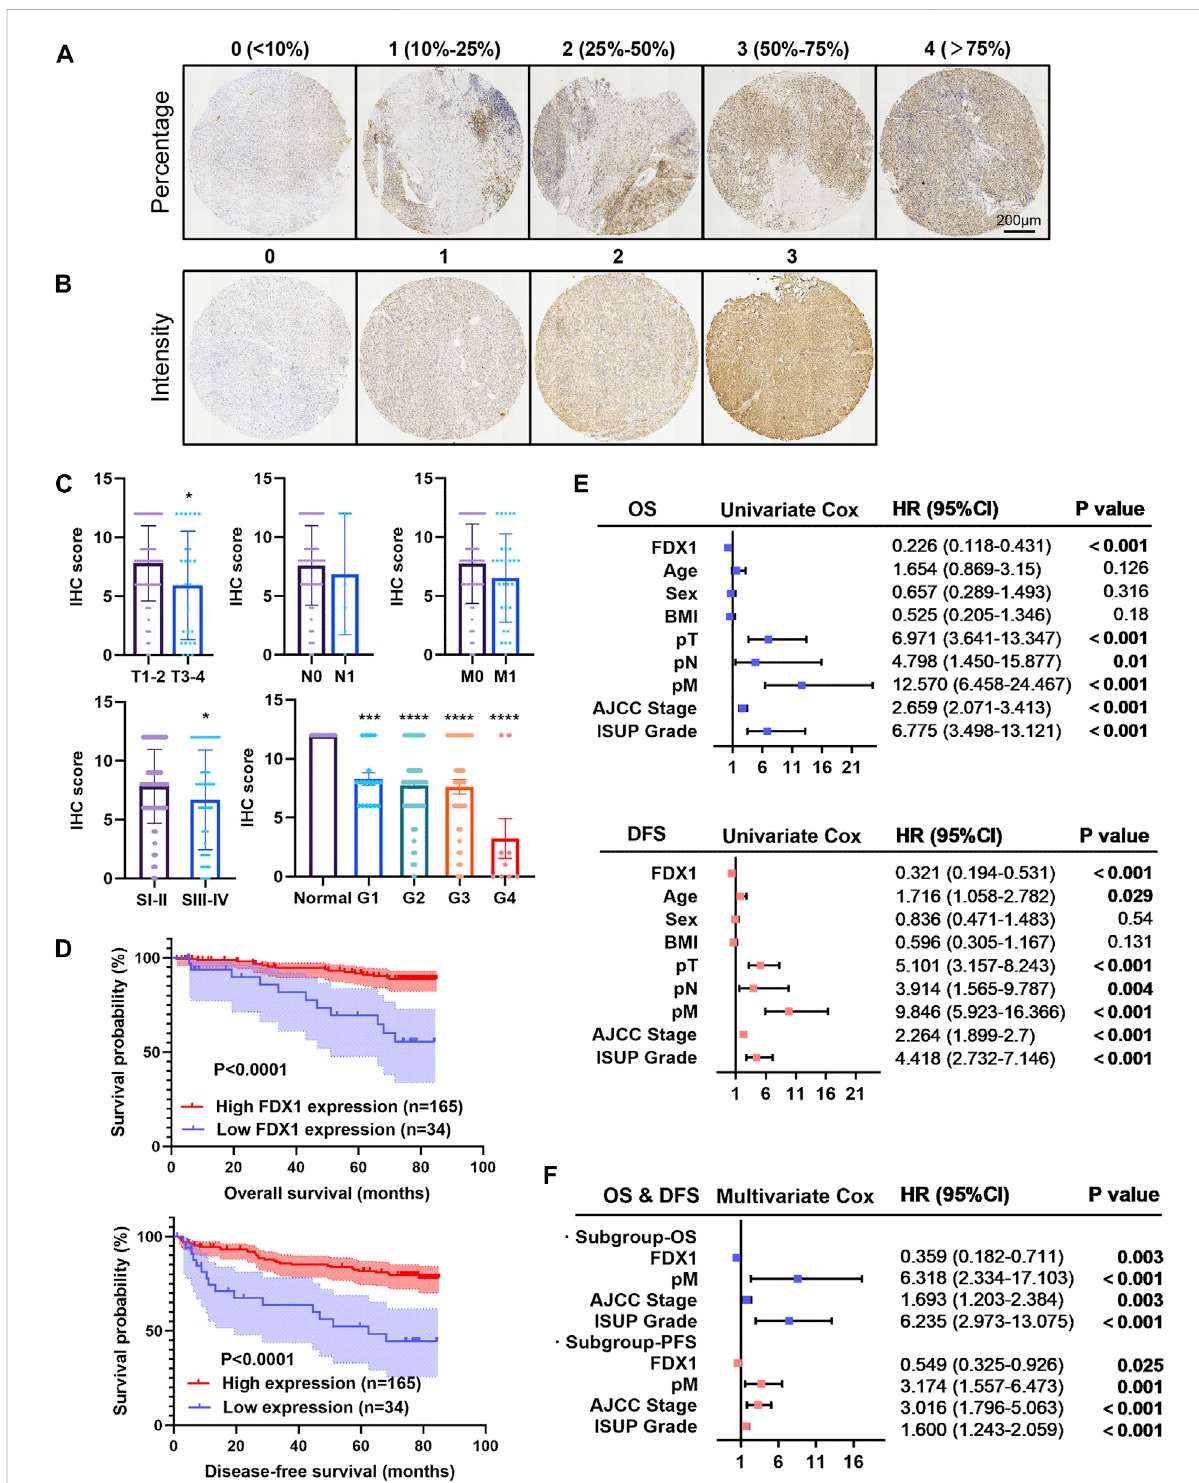
FIGURE 5 Tissue microarray analysis of FDX1 expression in 199 patients and its prognostic signi fi cance in ccRCC. (A , B) Immuno-histochemistry of TMA and scoring according to the positive stain percentage (score 0 – 4) and intensity (score 0 – 3). (C) Bar chart exhibited the quanti fi cation of the immunohistochemistry score betweengroups with a p value. (D) Kaplan-Meier survival analysis demonstrated thepositive OS andDFSprobability of ccRCC patients with a greater FDX1 expression. (E) Univariate Cox analysis for overall survival and disease-free survival in the cohort in relation to clinicopathological factors (including FDX1 expression, age, gender, BMI, pT, pN, pM, AJCC stage, and ISUP grade). (F) Forest plot for the multivariate Cox analysis for overall survival and disease-free survival. * p < 0.05, *** p < 0.001 and **** p < 0.0001 vs. para-tumour